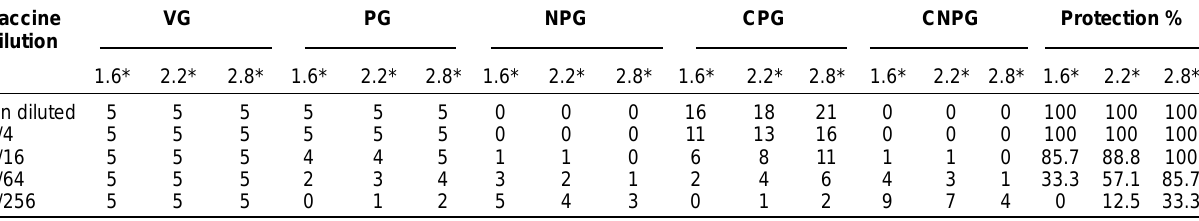
Table-2. GPPD of FMD virus type O panAsia-2 with different 146S content vaccine 50 Vaccine